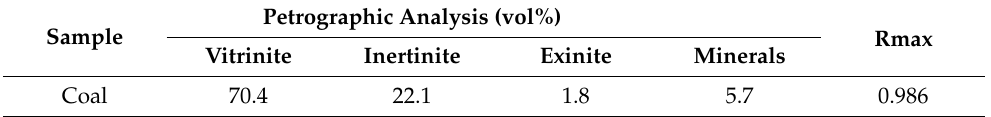
Table 3. Petrographic analysis and vitrinite reflectivity of Hailar coal